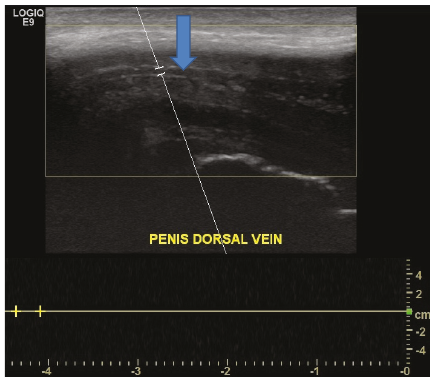
Figure 2: Penile ultrasound with the arrow directed towards Doppler noting absence of flow in dorsal